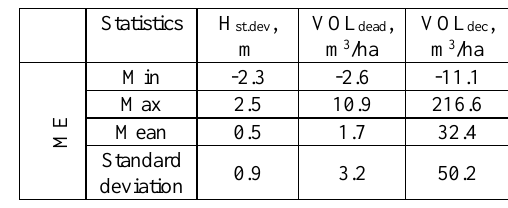
Table 3. Accuracy of mapping biodiversity indicators. ME